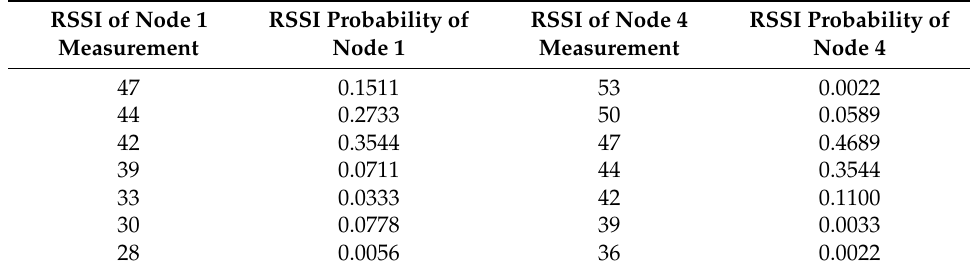
Table 8. Collecting RSSI data of Node 1 and Node 4 at 3 m.